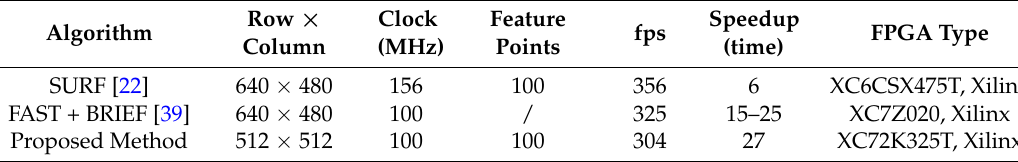
Table 3. Comparison with previous work.